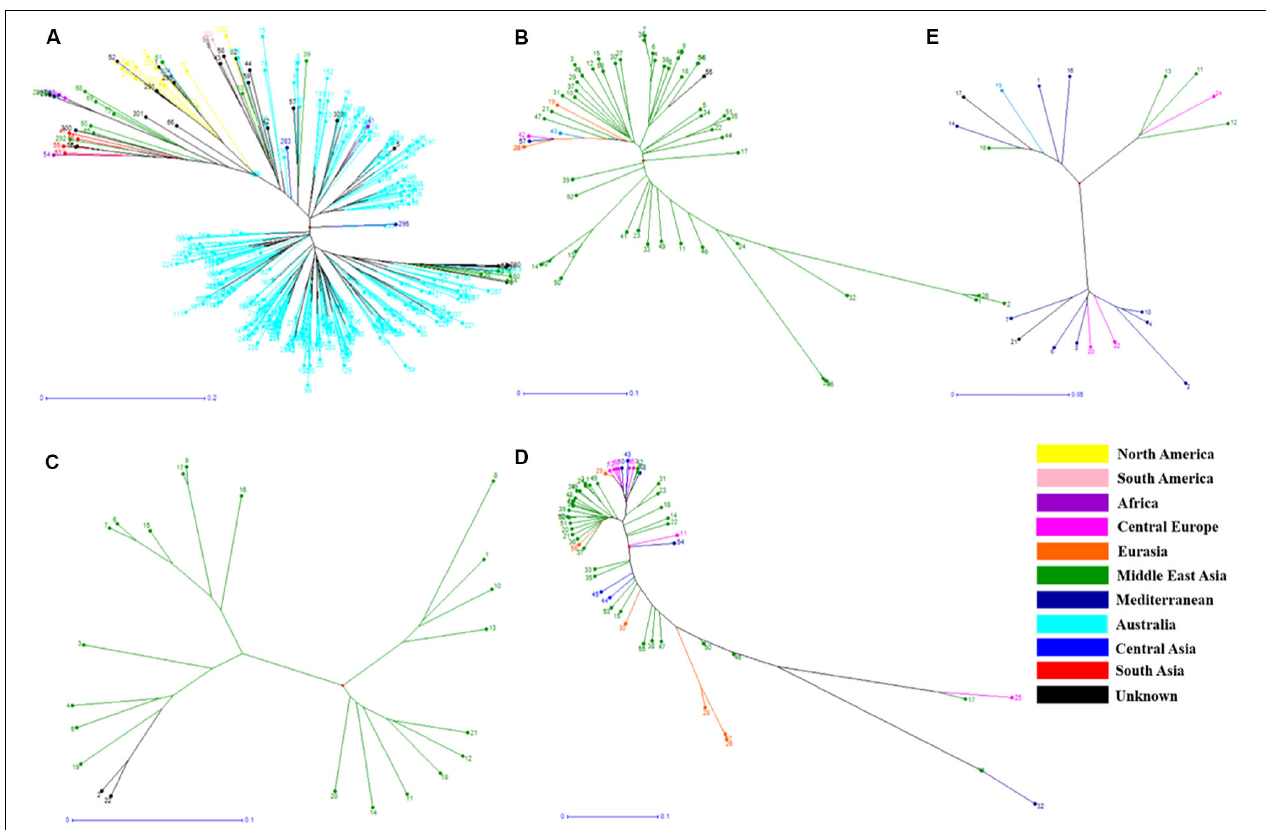
FIGURE 3 | Phylogenetic trees from different Lens species based on their geographical origin. (A) L . culinaris , (B) L . orientalis , (C) L . odemensis , (D) L . ervoides , and (E) L . nigricans . The accessions are color coded according to the details listed in Supplementary Table S2